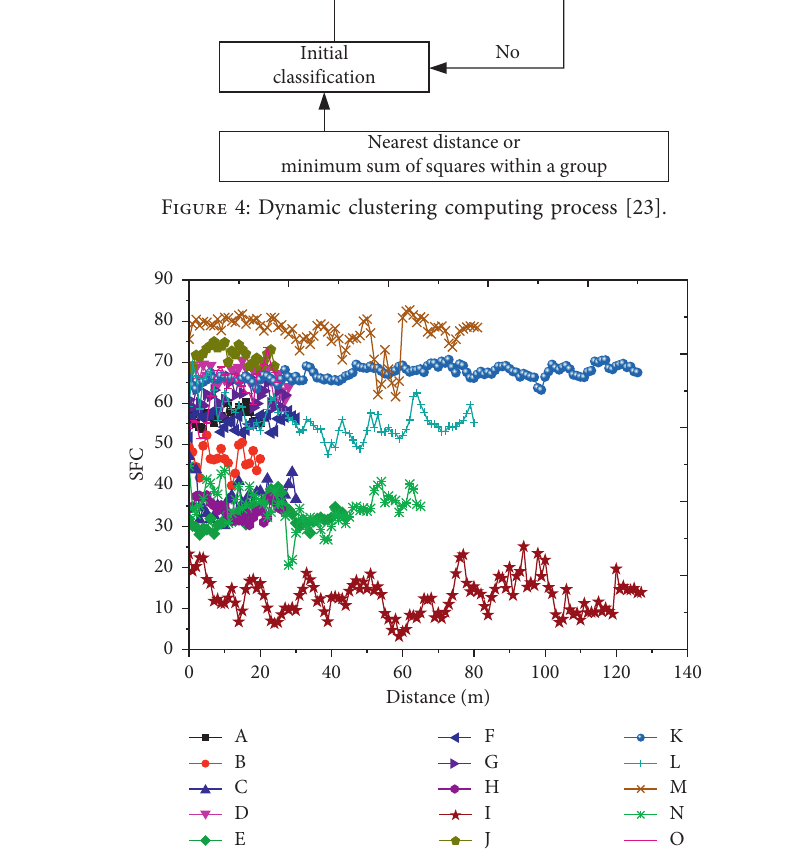
Figure 5: Test results of different pavement skid